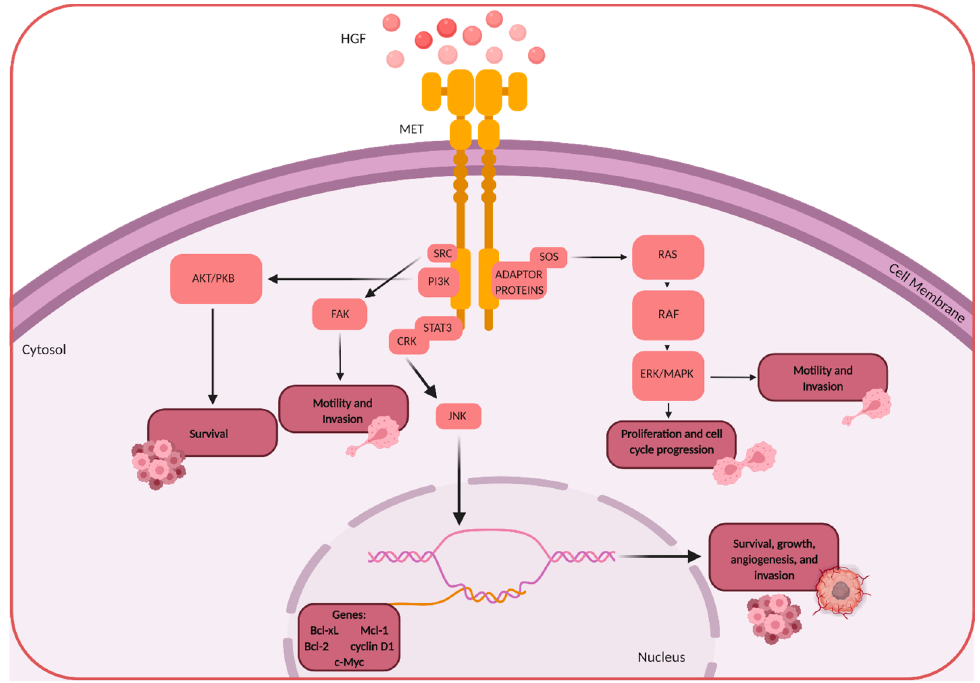
Figure 2. Select signaling pathways that are triggered by HGF/MET binding and activation, leading to important survival-promoting pathways in